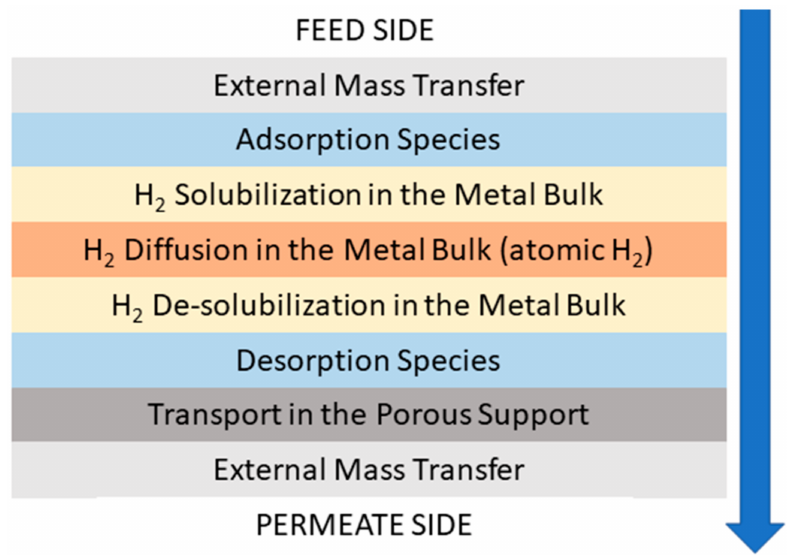
Figure 17. Solution-diffusion mechanism of the permeation of H 2 through a Pd-based mem- brane